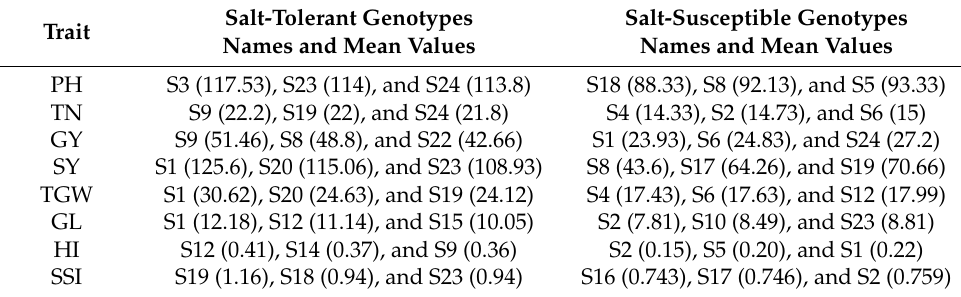
Table 4. Performance of 24 GSR lines under field